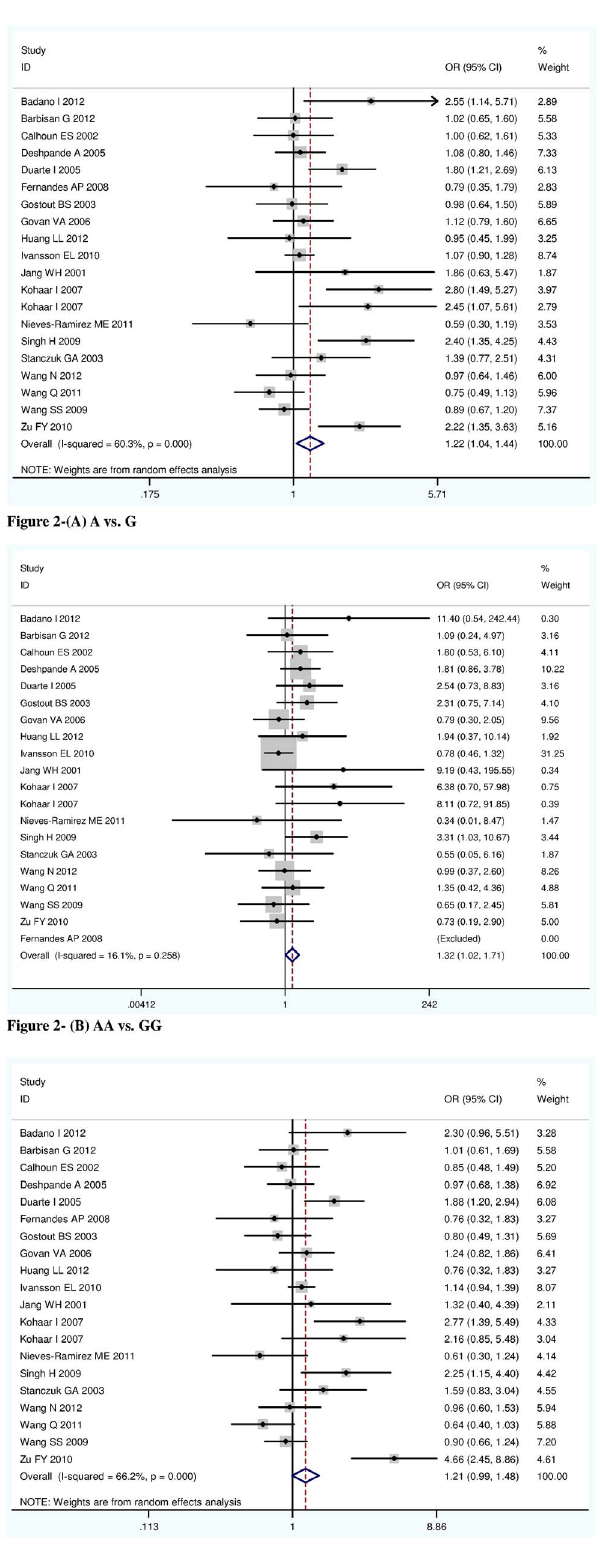
Figure 2. Forest plot describing the association between TNF- a rs1800629 polymorphism and cervical lesions risk. (Each study is shown by the point estimate of the OR and 95% CI, and (the size of the square is proportional to the weight of each study.) Figure 2-(A) A vs. G. Figure 2- (B) AA vs. GG. Figure 2- (C) AA/GA vs. GG.